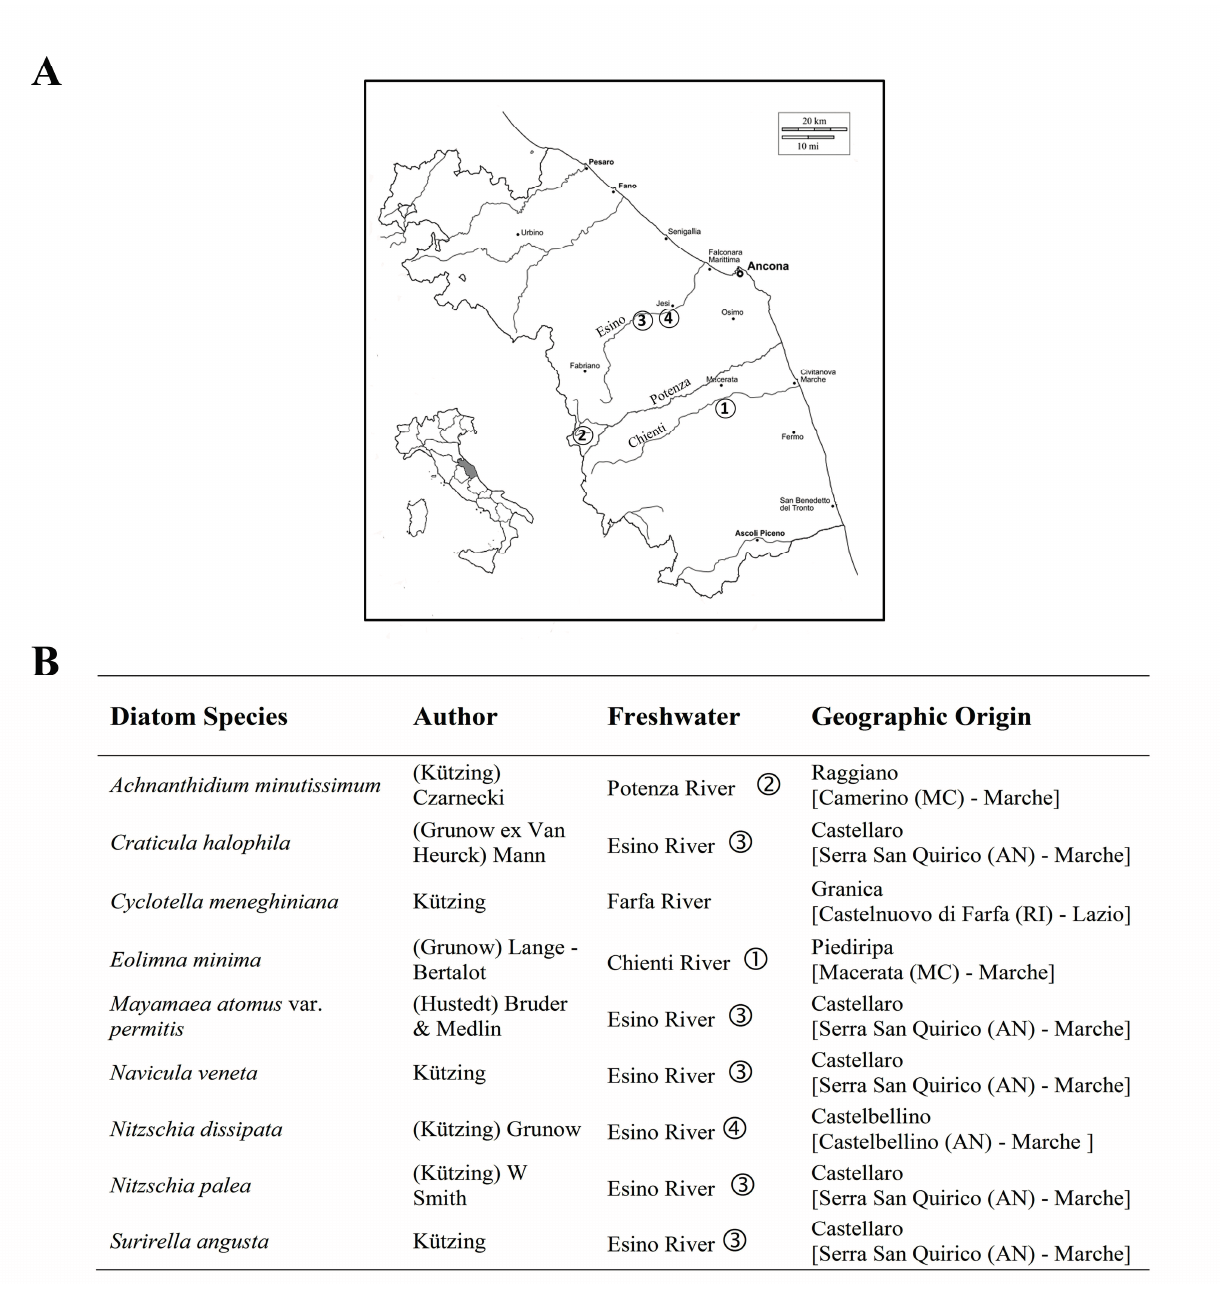
Figure 1. ( A ) Map of sampling sites in Regione Marche (Italy) and ( B ) list of diatoms species isolated and used in this